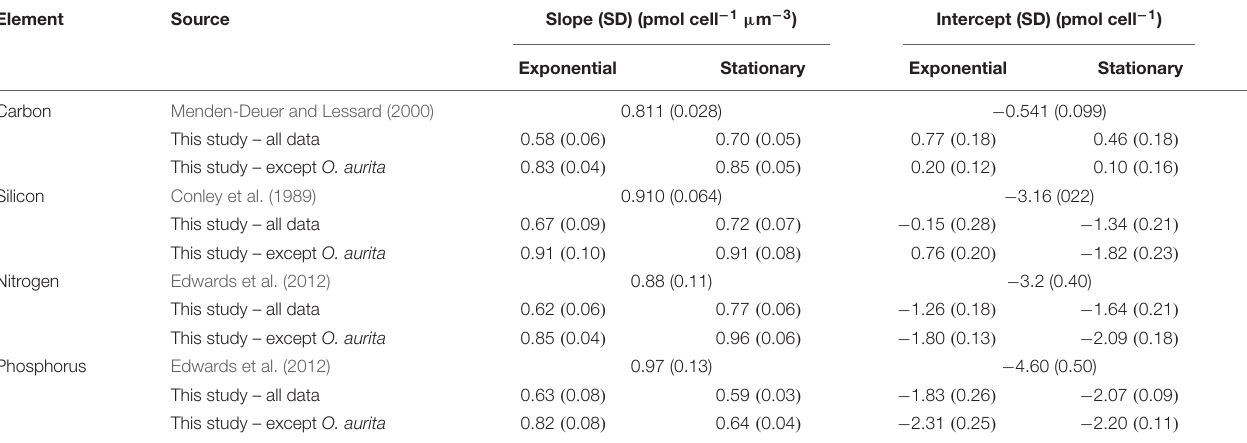
TABLE 2 | Comparison of the log–log relationships of cell element quota versus cell biovolume. Element